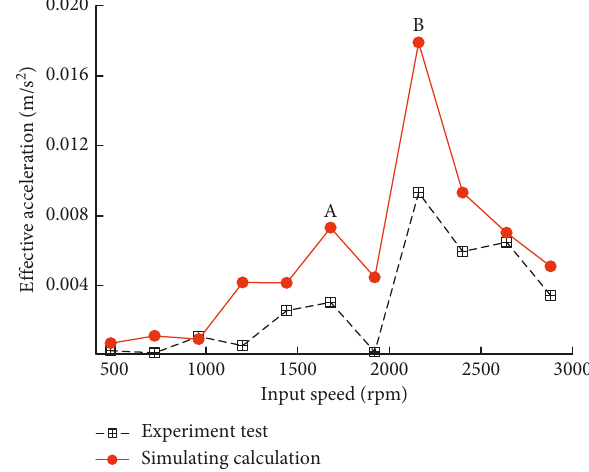
Figure 19: Comparison of simulation and experiment